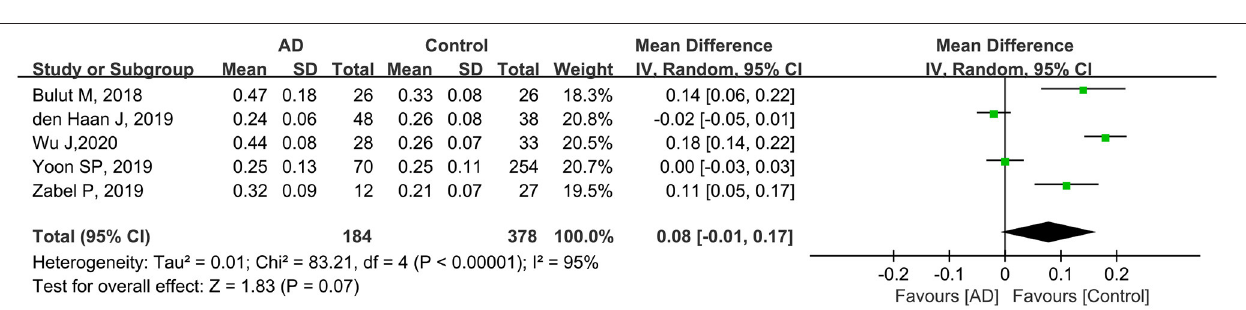
FIGURE 7 | Forest plot for parafoveal superficial and deep vessel density in 6 × 6-mm scan size between AD and control groups.